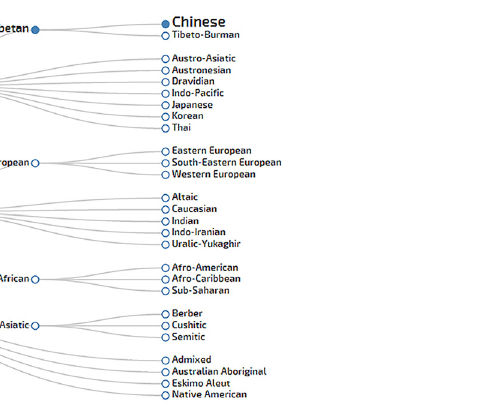
Fig 1. A cluster structure based on haplotypes of the Liaoning Han population in the YHRD database.